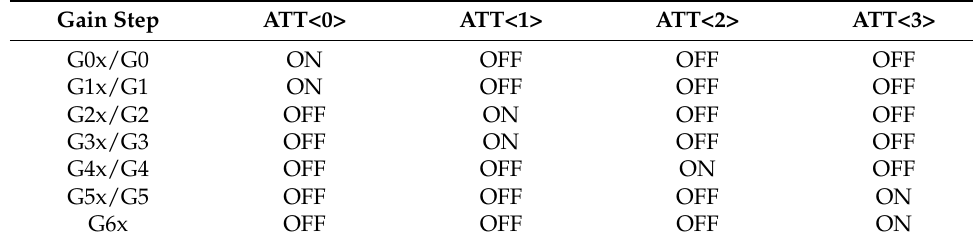
Figure 2. Block diagram of proposed input-attenuator. Table 1. Programmable digital control bits of input-attenuator.